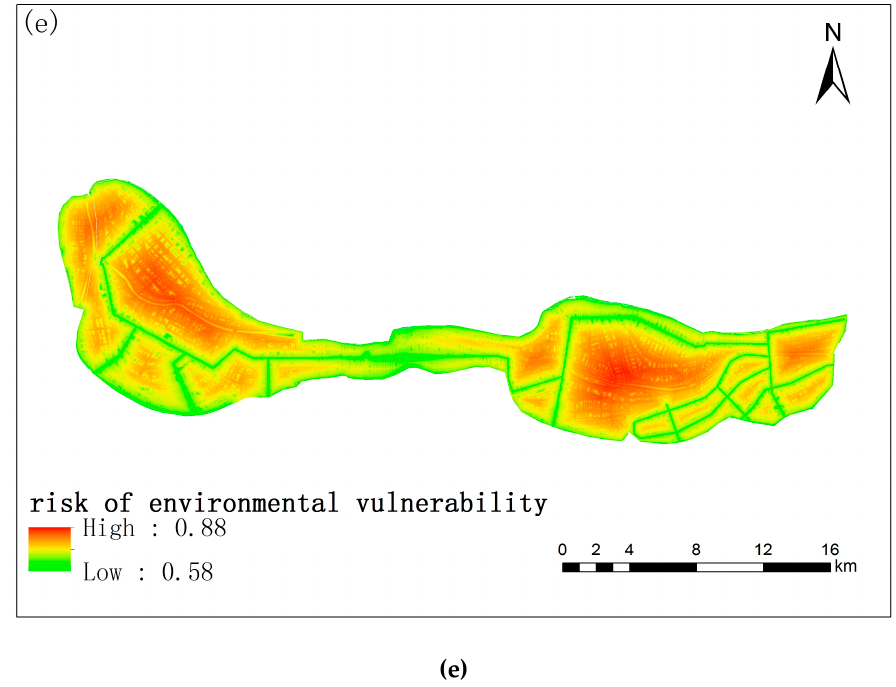
Figure 10. Butterfly catastrophe calculations for environmental vulnerability. ( a ) Butterfly catastrophe of ground elevation, ( b ) butterfly catastrophe of ditches, ( c ) butterfly catastrophe of river systems, ( d ) butterfly catastrophe of road networks and ( e ) risk of environmental vulnerability.